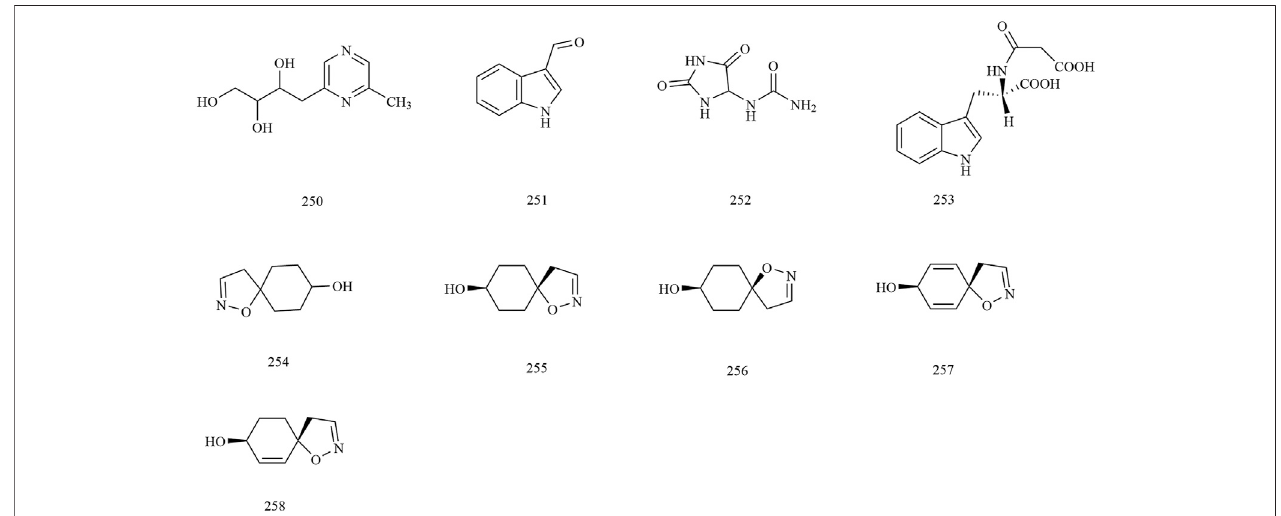
FIGURE 8 | Structures of alkaloid compounds in X. sorbifolium .